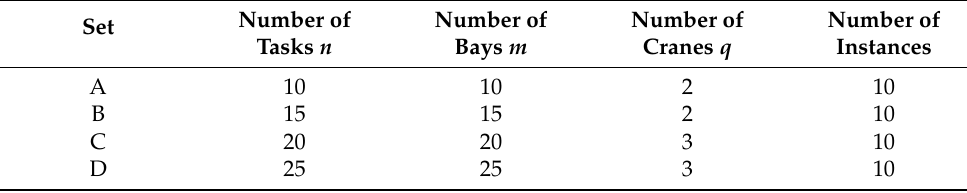
Table 4. Instance parameters.